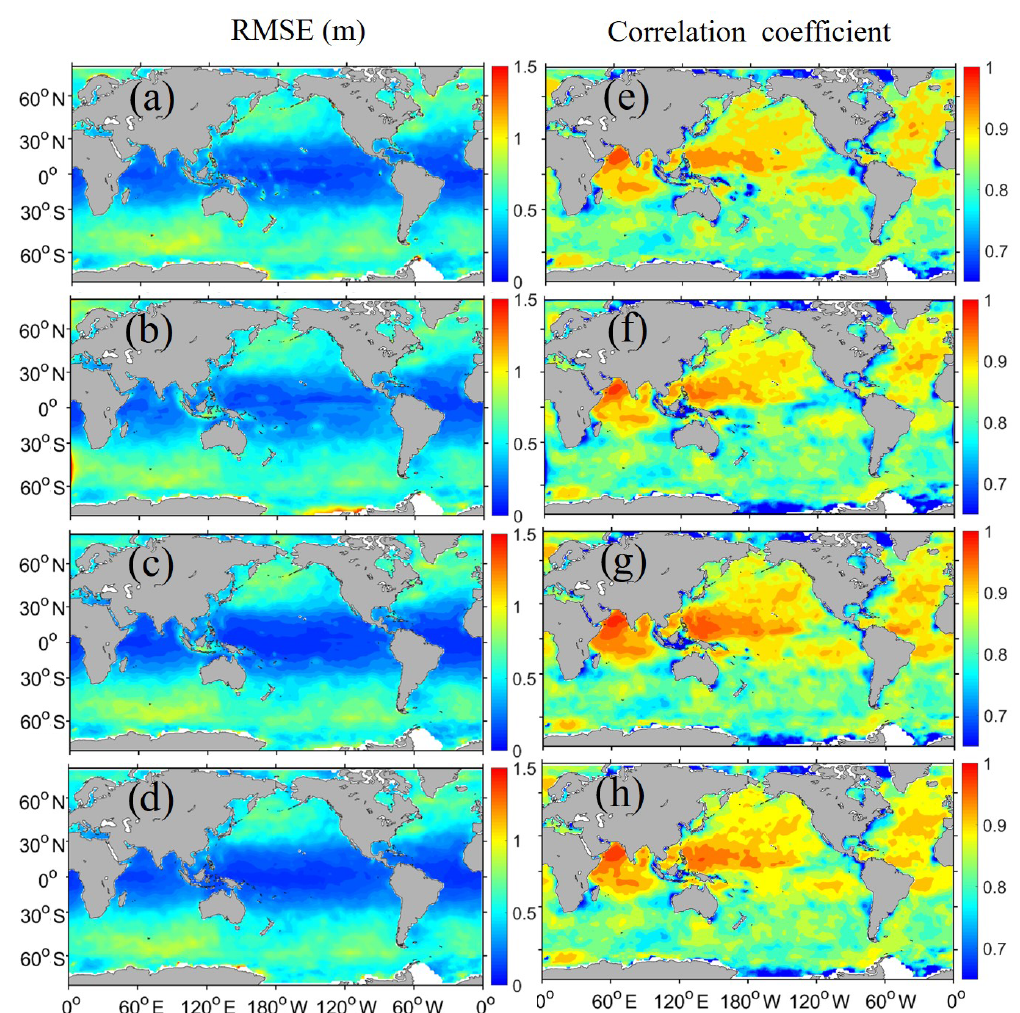
Figure 10. Distributions of SWH RMSEs (a–d) and spatial correlation coefficients (e–h) (against the merged grid altimeter data) of the WW3 (a, e) , SWAN (b, f) and WAM (c, g) assimilations and the bias correction with the second method (d, h) . The statistics are averaged over the entire 1-year assimilation